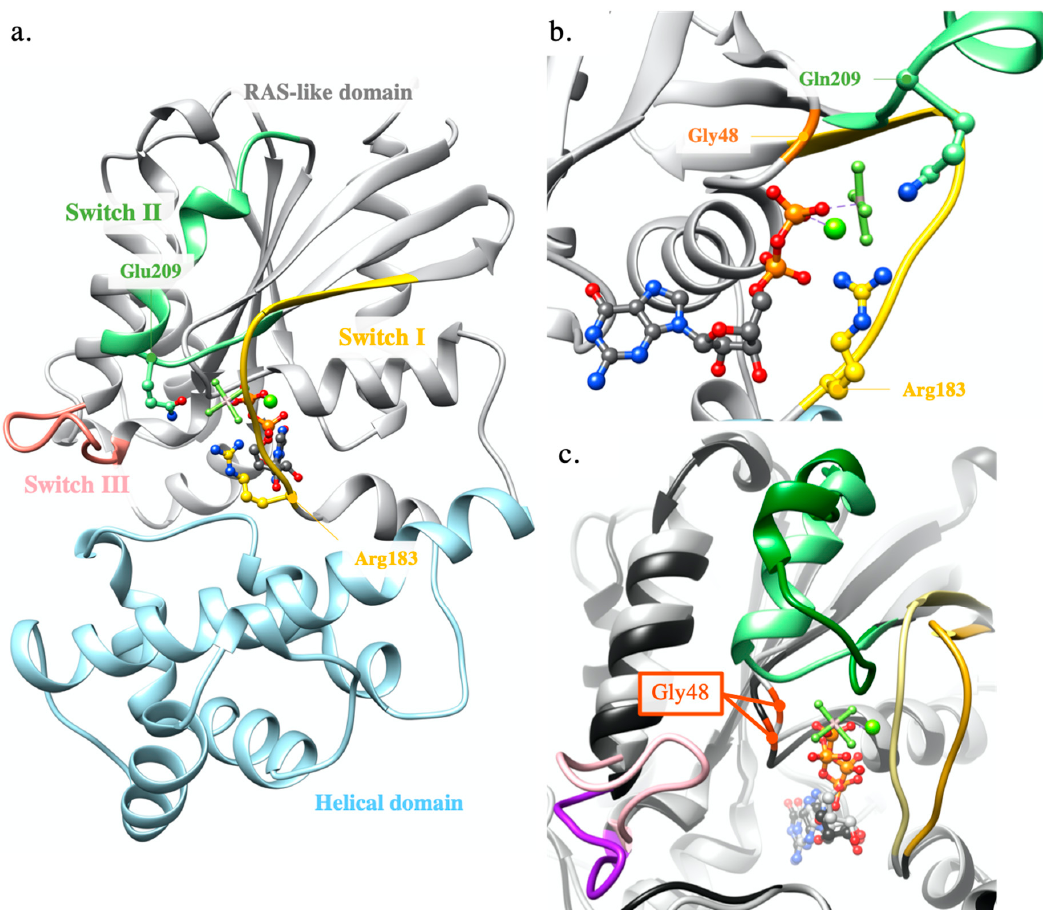
Figure 1. Switch regions and hotspots Arg183 and Glu209. ( a ) G α q active conformation co-crystallized with GDP, AlF4 and Mg 2+ . RAS-like and helical domains are represented in ribbons colored in grey and blue, respectively. GDP and AlF4 are shown in ball and stick and the Mg 2+ in sphere representations, respectively. SW-I (183–192), SW-II (206–222) and SW-III (236–246) are, respectively, colored in gold, green and salmon (Protein Data Bank, PDB ID 3ohm); ( b ) zoom on the hotspots Arg183 and Gln209 and the active site. Gly48 is colored in orange (PDB ID 3ohm); ( c ) superimposition of the active (grey) and inactive (black) conformations of G α q/i. SW-I are in yellow/goldenrod, SW-II in light-green/dark-green, SW-III in pink/purple. The G α q active conformation was obtained as a co-crystal with GDP, AlF4 and Mg 2+ (PDB ID 3ohm) [7] and the G α q/i inactive conformation as a co-crystal with GDP (PDB ID 3ah8) [8] .